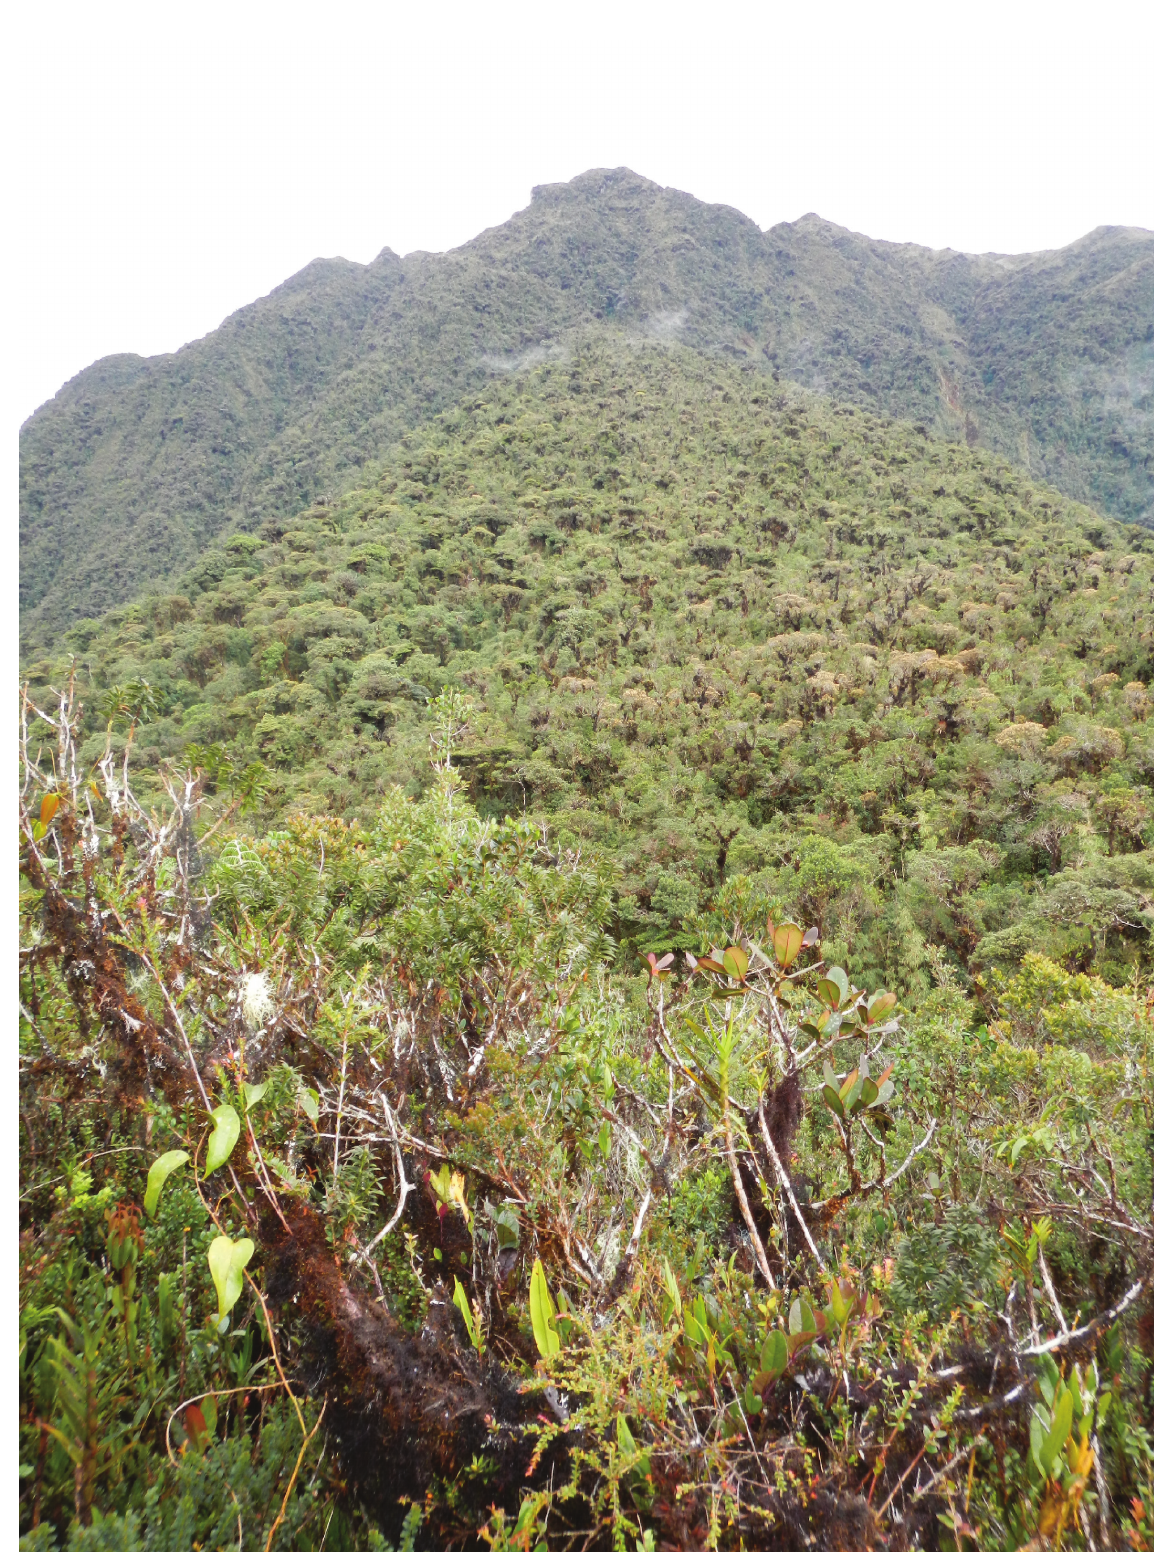
Fig. 7. Type locality of Pristimantis boucephalus sp. nov. in the Yanachaga-Chemillén National Park. Photo by E.